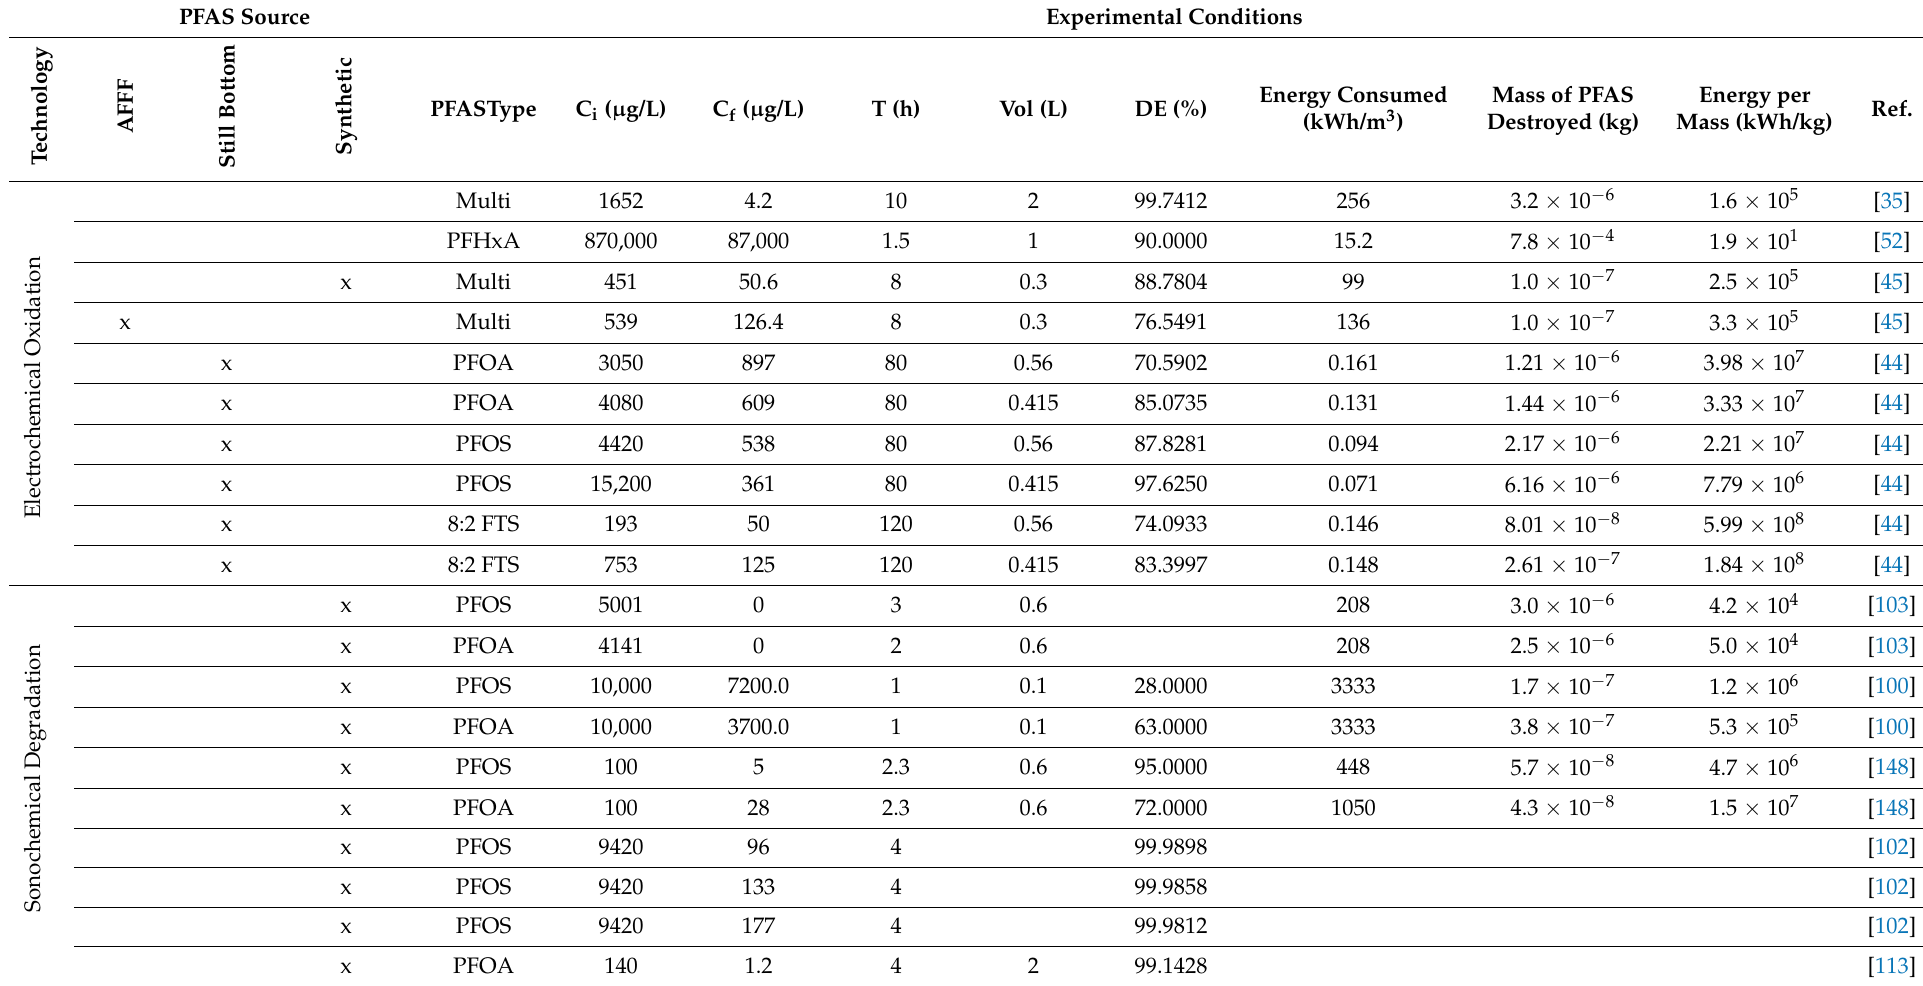
Table 1. Comparison of published PFAS destruction technologies investigation on water